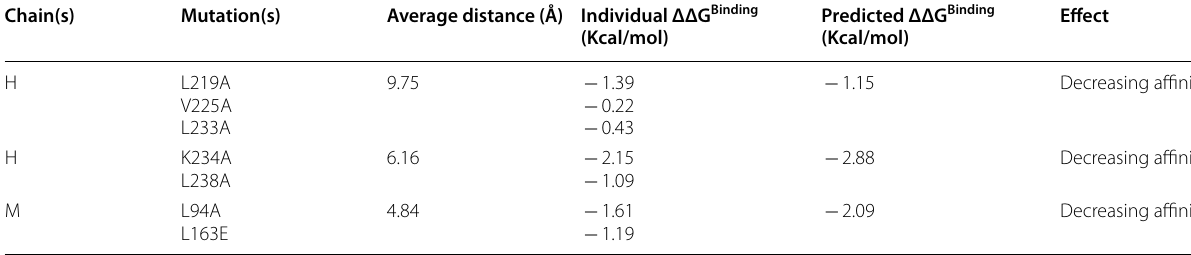
Using the 3D structure of the wild-type complex as input file, the tool display details about the mutated chains, mutated residues, average distance of the mutated residue from its closest interacting partner, individual binding free energy change in Kcal/mol, average (predicted) binding free energy change in Kcal/mol, and the impact of each mutation on the binding affinity of the complex